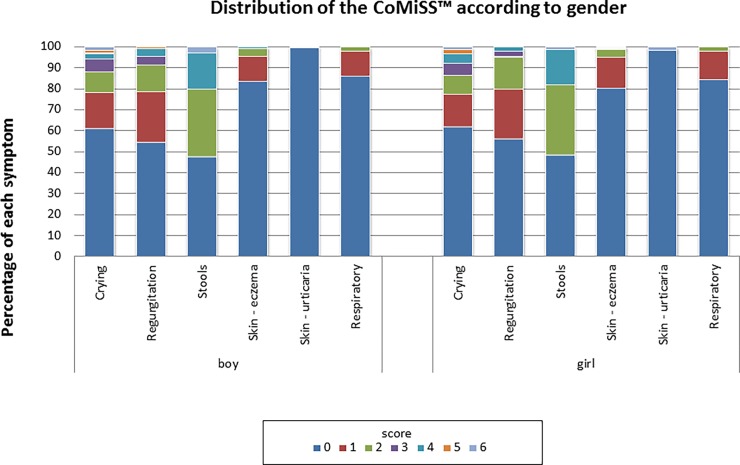
Distribution of CoMiSS according to gender.